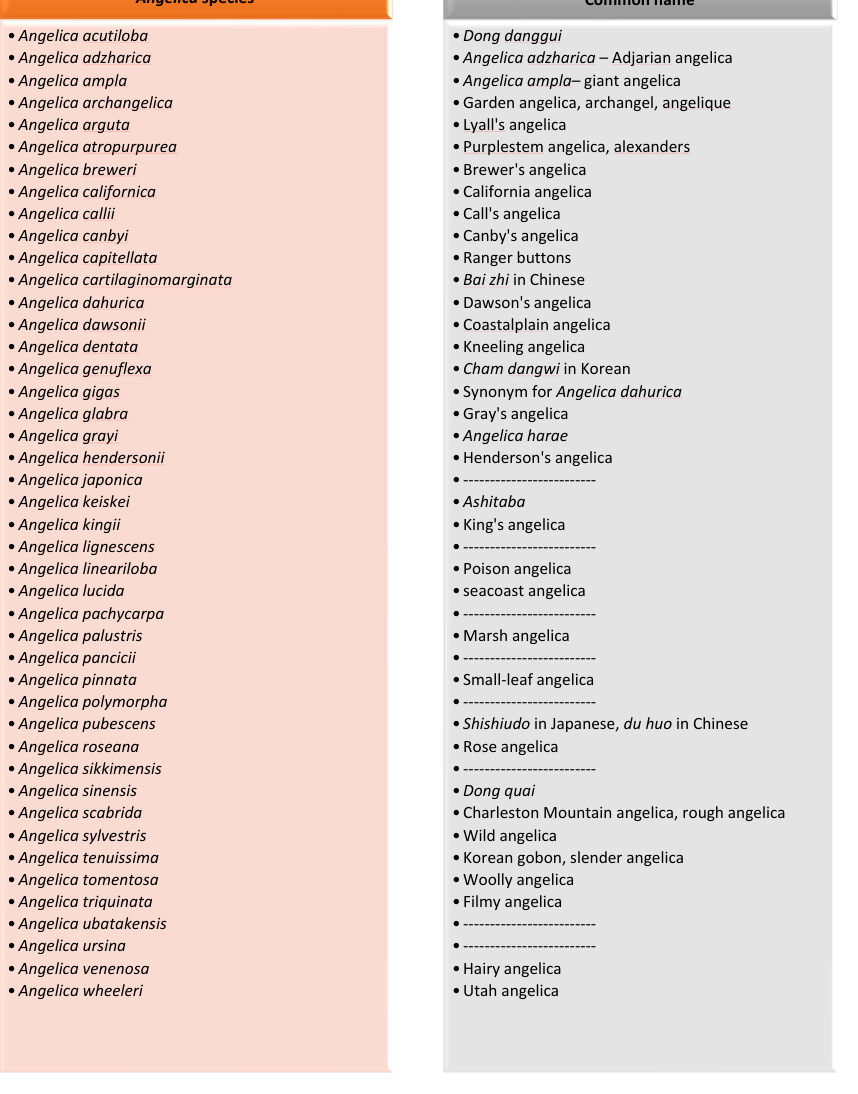
Figure 1. Diagram showing different Angelica species.